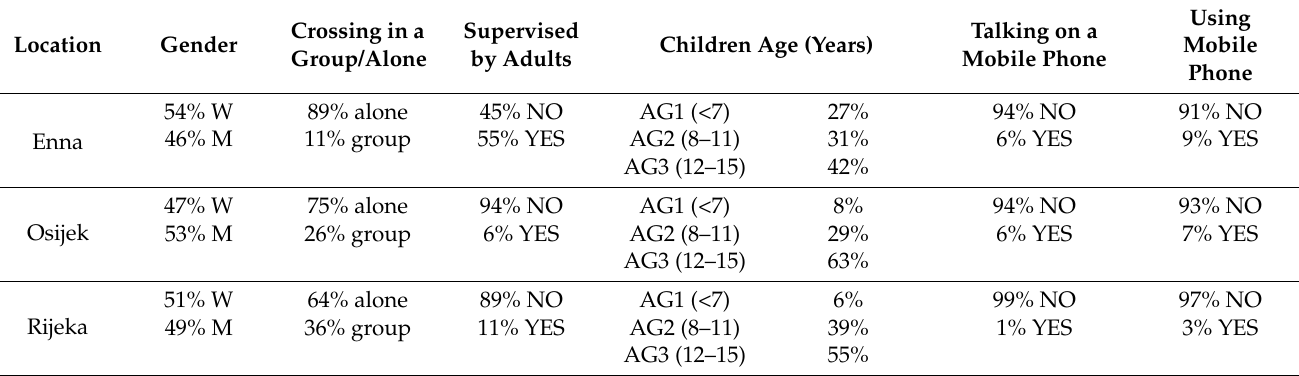
Table 5. Main features from analyzed